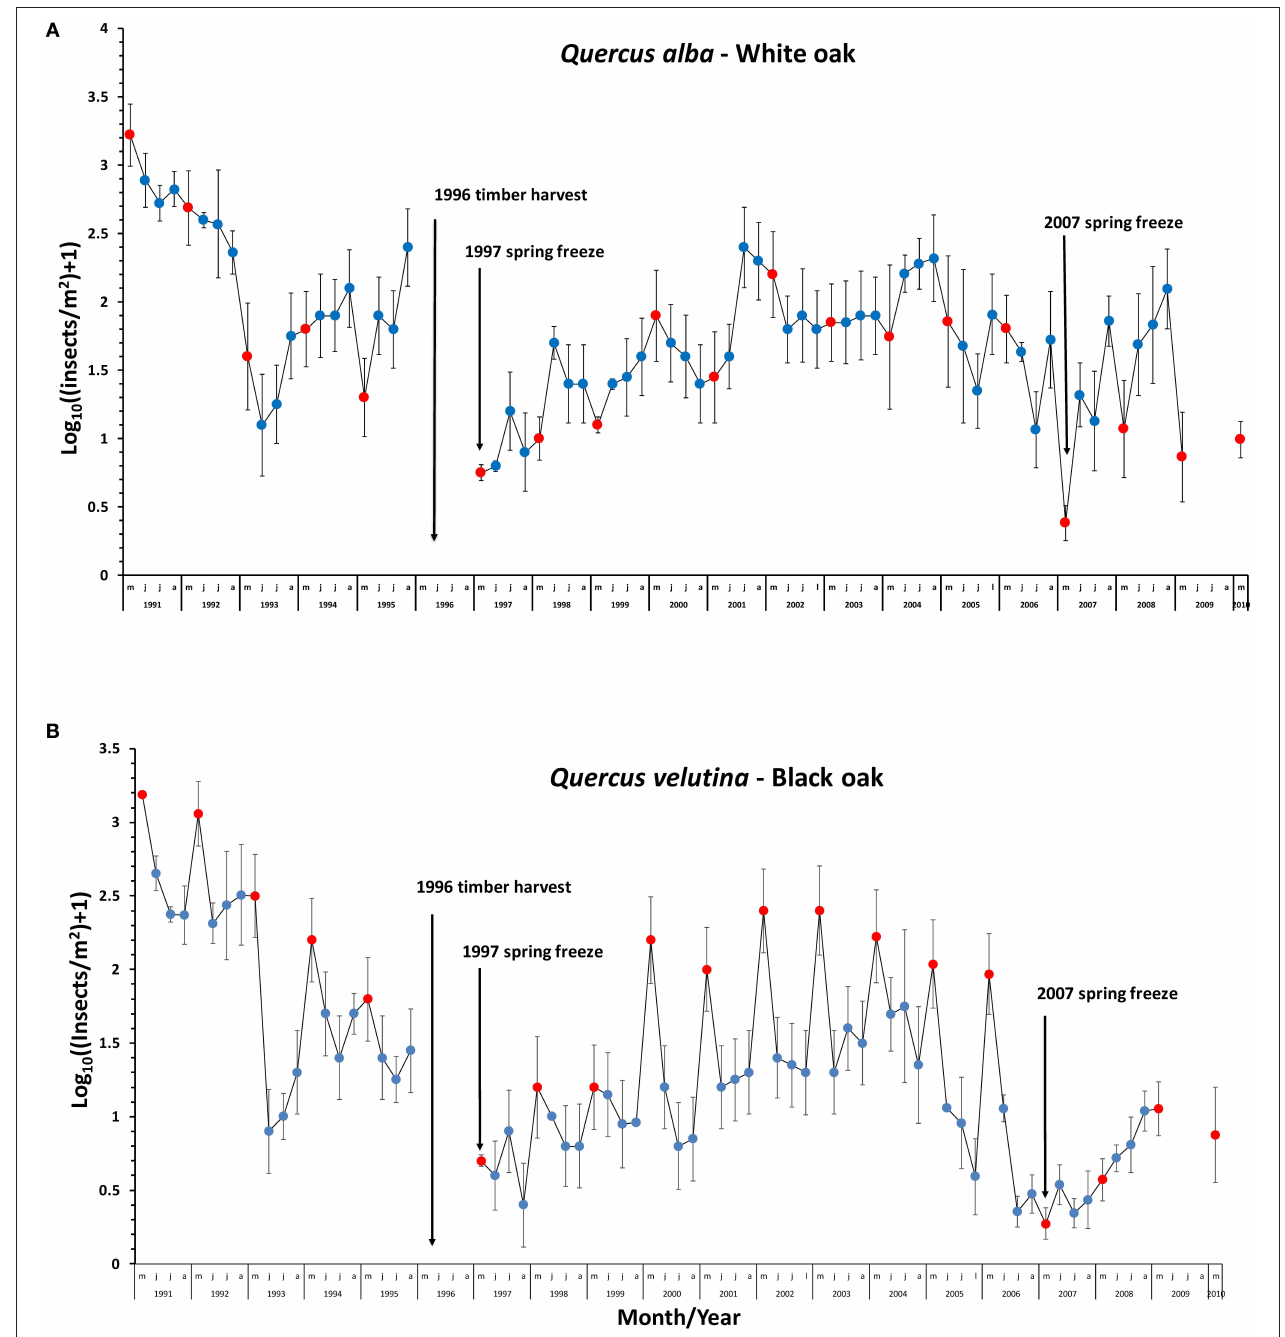
FIGURE 1 | Effect of mid spring freezes (indicated by vertical black arrows, 1997 and 2007) on mean abundance of leaf chewing insects on (A) Quercus alba and (B) Q. velutina in Missouri Ozark Forest Ecosystem Project (MOFEP) control plots, southeastern Missouri. Red dots and blue dots indicate values for the spring (May) and summer (June-August) communities, respectively. Timber harvest in MOFEP occurred in 1996, during which data collection was prohibited. Values for each point are means of means (site/stand) for one (1991), six (1992–2008), or two stands (2009–2010) for each of three control sites in the MOFEP. Error bars are 95% confidence intervals for each point. Note that data are presented on a log 10 scale. No sampling occurred September through April, when there are few insects, and/or no leaves on trees (mid-October to March or later). February 1 to May 31 2007 r = 0.995, P < 0.0001, minimum daily temperature for February 1-May 31 2007 r = 0.9751, P <